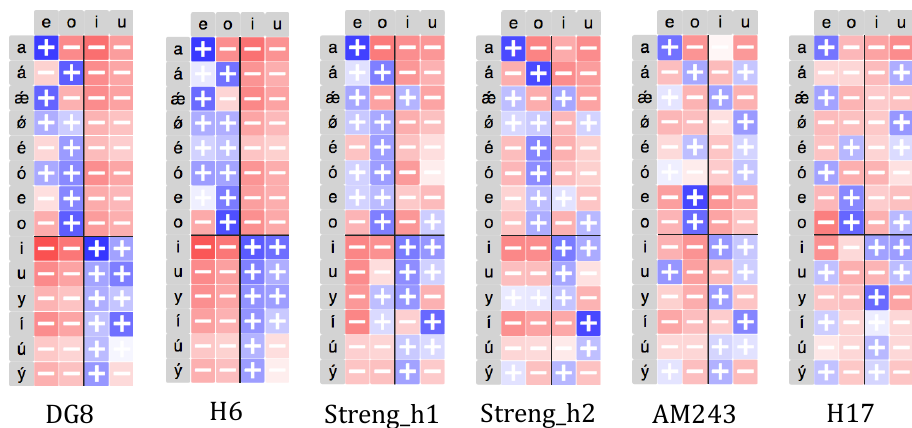
Figure 5: Sample of PhonMatrix visualisations of Old Norwegian harmony